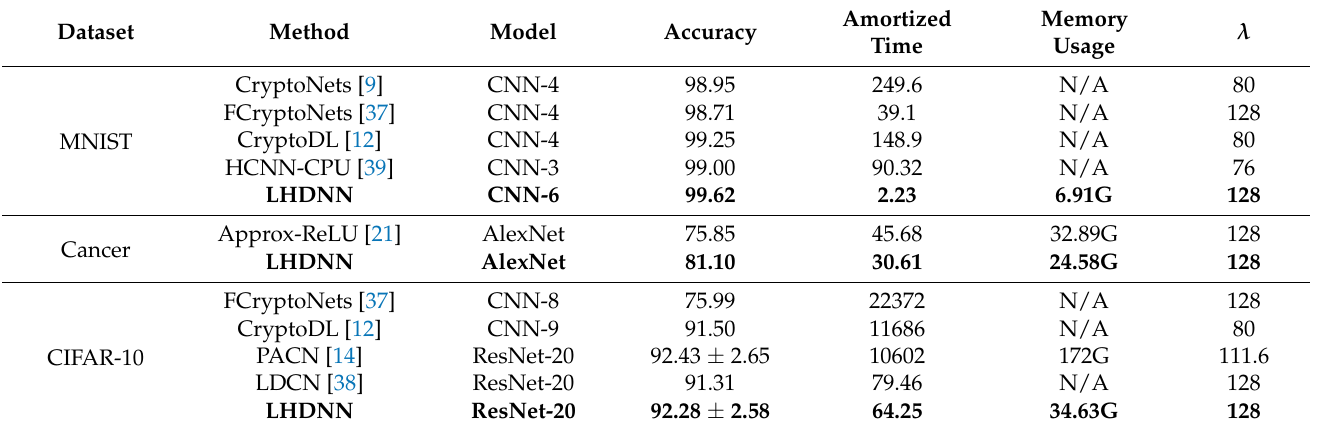
Table 6. Comparison of ciphertext inference